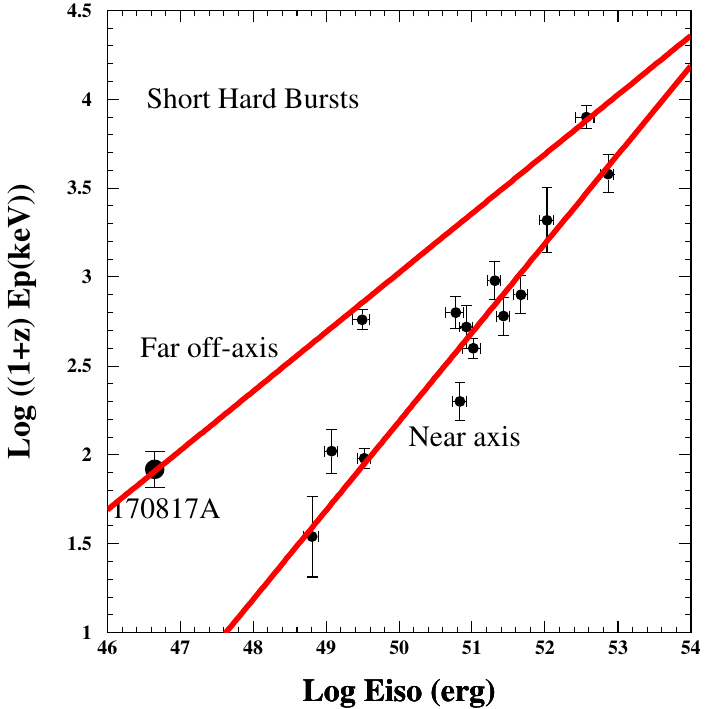
Figure 5. The [ E p , E iso ] correlations in SHBs. The lines are the CB model predicted correlations as given by Equations (4) and